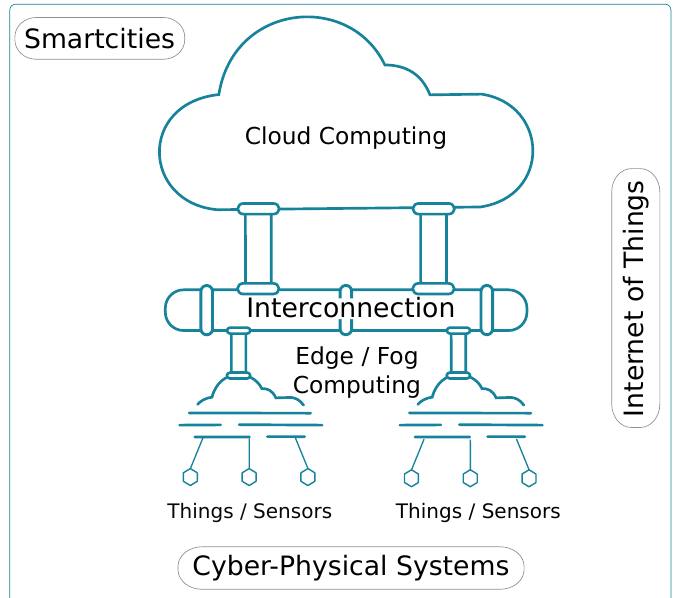
Figure 1. Smart city